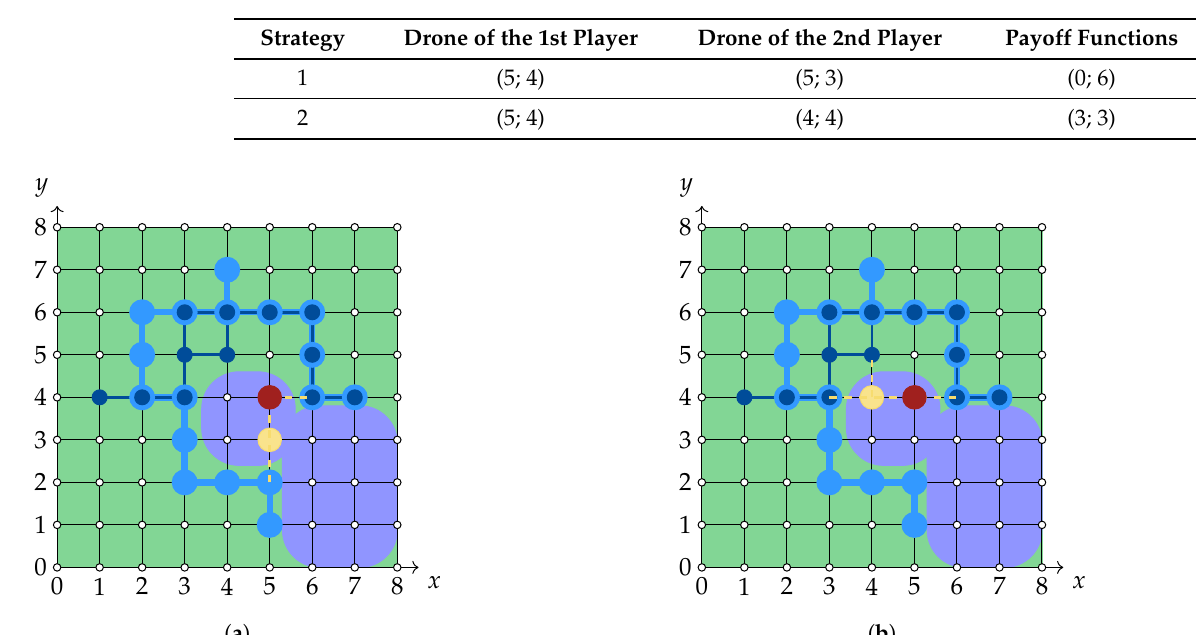
Table 3. Optimal strategies: Network 2.